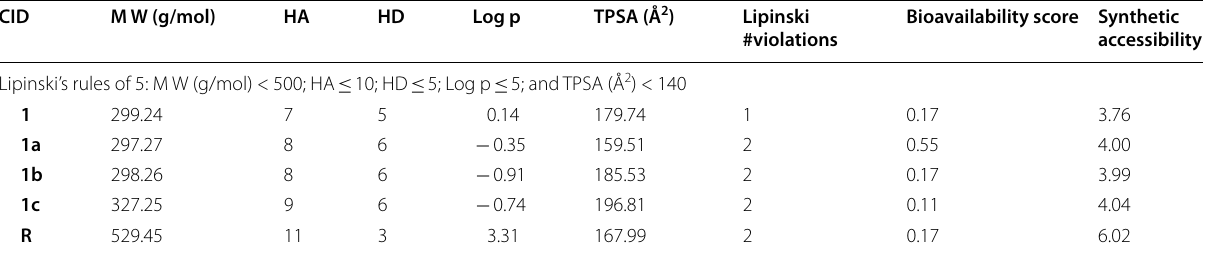
Table 3 The drug-likeness for molecule 1 , designed molecules ( 1a – 1c ), and Sofosbuvir as reference inhibitor ( R ) CID M W (g/mol) HA HD Log p TPSA (Å 2